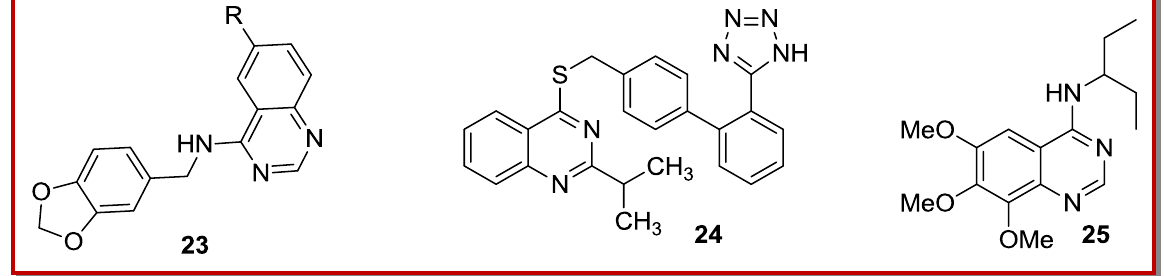
Figure 12: Selected quinazoline motifs with notable PDE inhibitory efficiency SHR SHR -